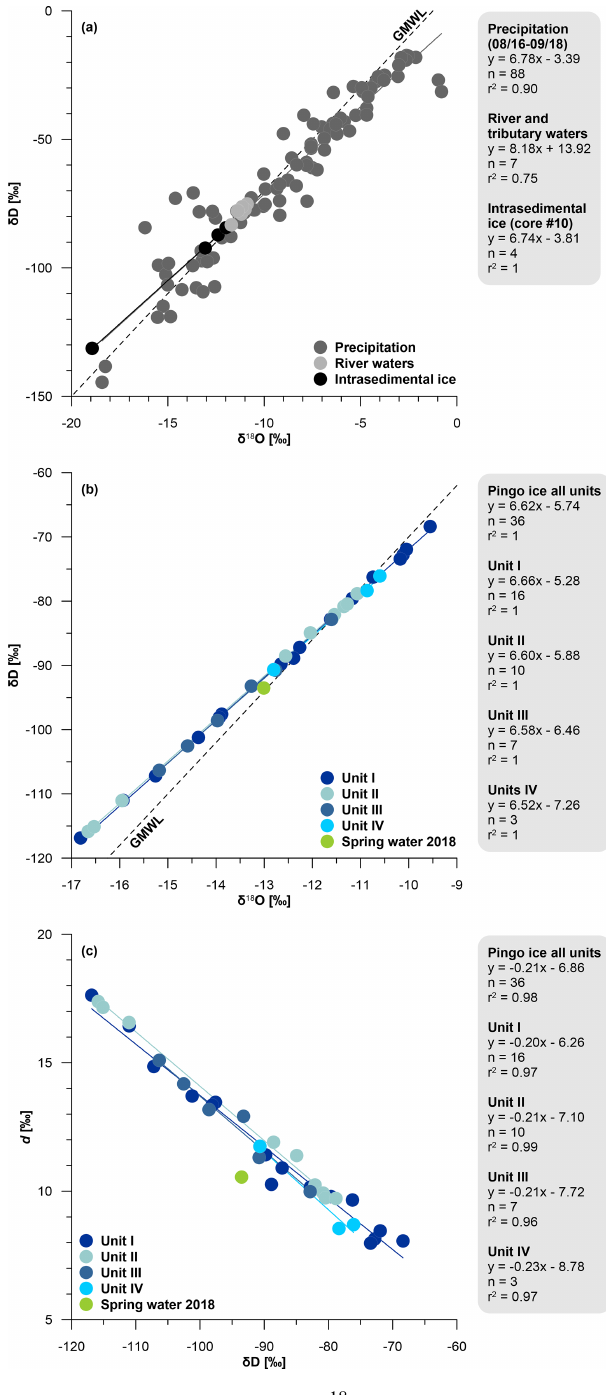
Figure 3. Co-isotopic plots of (a) δ 18 O and δ D in modern precipi- tation (August 2016–September 2018) and water of the Grøn River and its tributaries (Skakun et al., 2020), (b) δ 18 O and δ D in massive ice of core 9 from pingo and from spring water sampled, and (c) δ D and deuterium excess ( d ) data in massive ice of core 9 from pingo and from spring water. Data are given in Table 1. Note different axis scales in (a) and (b)